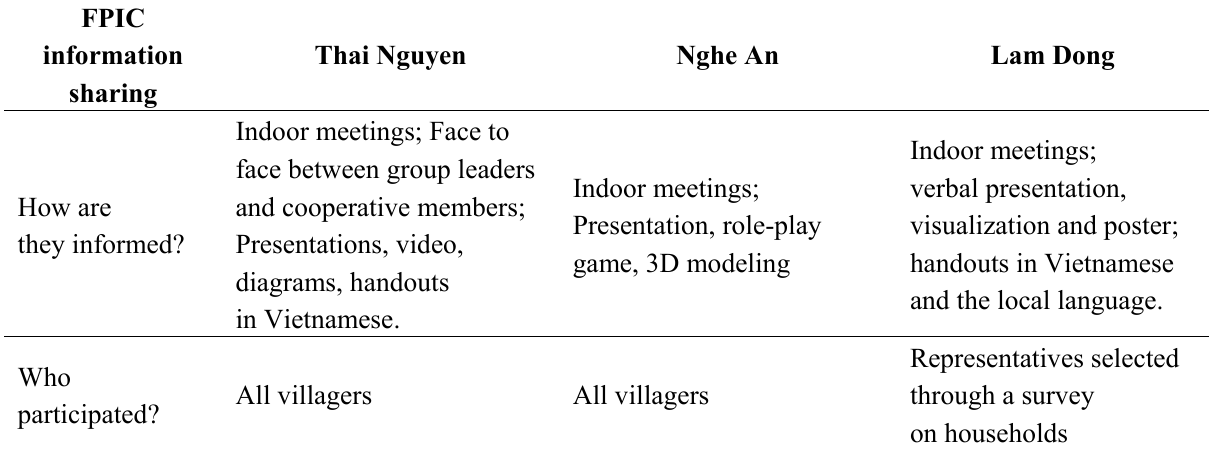
Table 3. How and where information was provided at the three